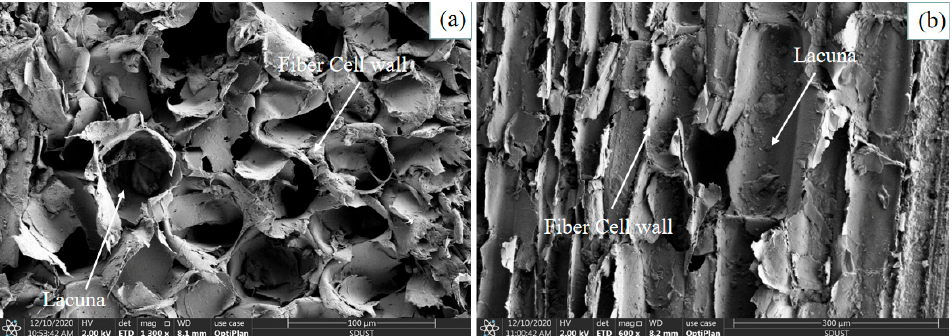
Figure 6. SEM micrographs of ( a ) cross-section of Rice straw fiber, ( b ) longitudinal section of straw fiber epidermis.